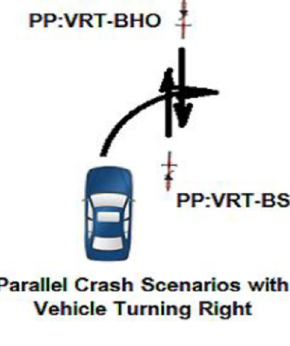
Figure 10 Crash geometry of PP:VRT scenarios